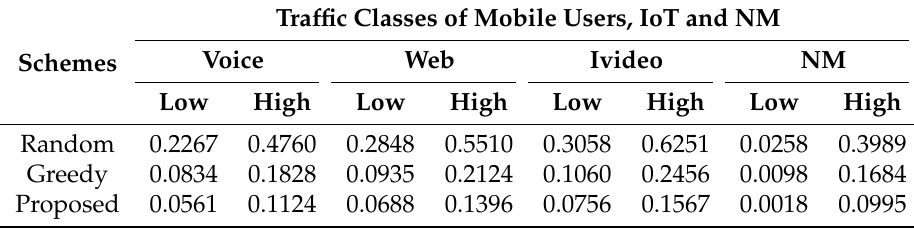
Figure 12. Blocking probability across different numbers of IoT devices. Table 5. Blocking probability of individual classes for low and high